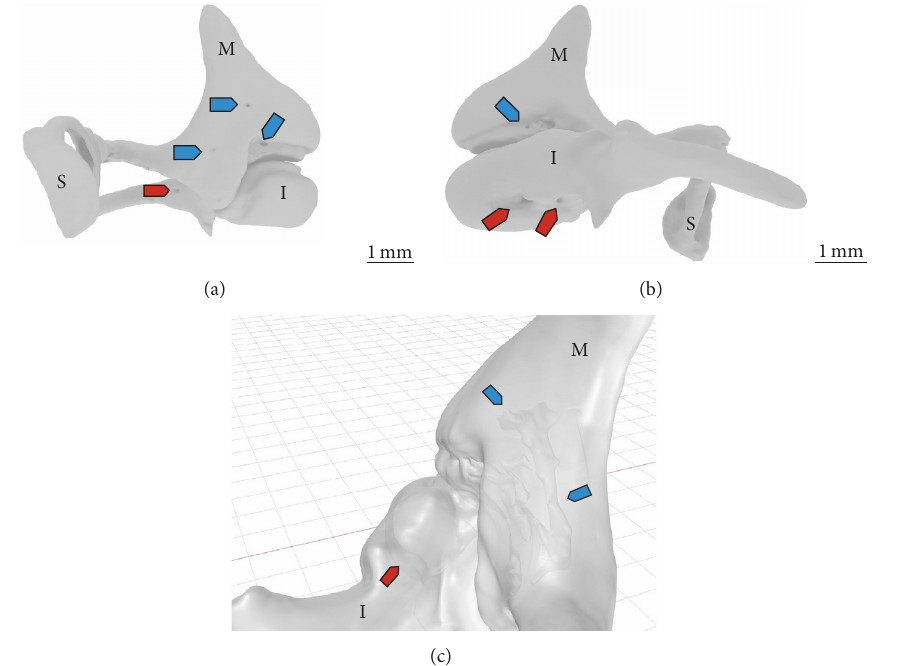
Figure 5: 3D model of the surface of the malleus (M), incus (I), and stapes (S) reconstructed by the 𝜇 CT dataset of the embedded specimen in the following orientations: medial (a) and lateral surface (b) of the auditory ossicles with the nutrient foramen on the malleus (blue arrow) and on the incus (red arrows). From the lateral side (c) the not calcified areas can be seen inside the half-transparent malleus (blue arrow) and incus (red